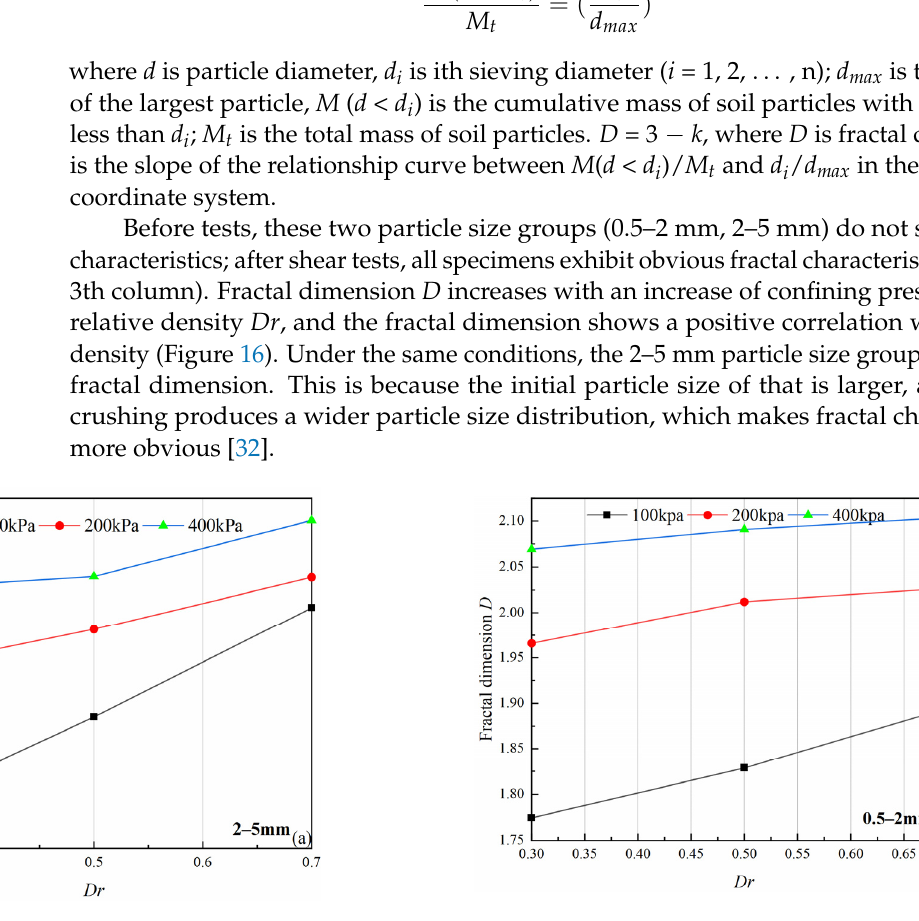
Figure 16. Variations in fractal dimension ( D ) with different relative density ( Dr ) and confining pressure( σ 3 ): ( a ) 2–5 mm particle groups; ( b ) 0.5–2 mm particle groups.